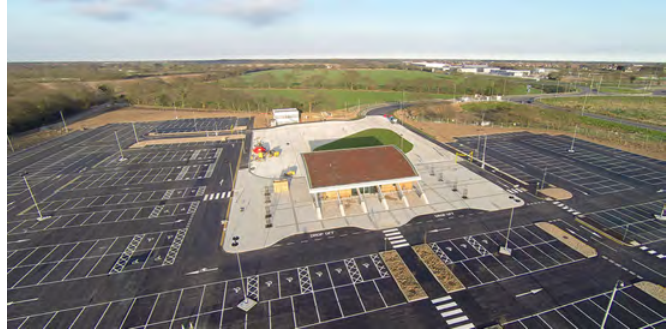
Figure 6. Colchester Park and Ride (Pick